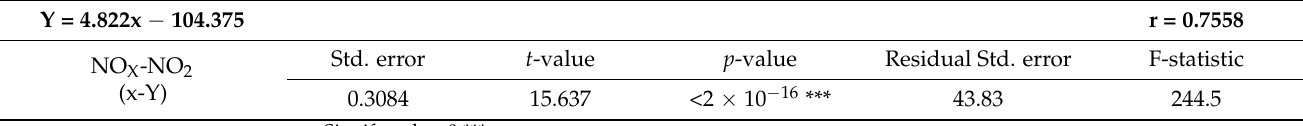
Table 6. Summary statistics from linear regression model for NO 2 and NO X